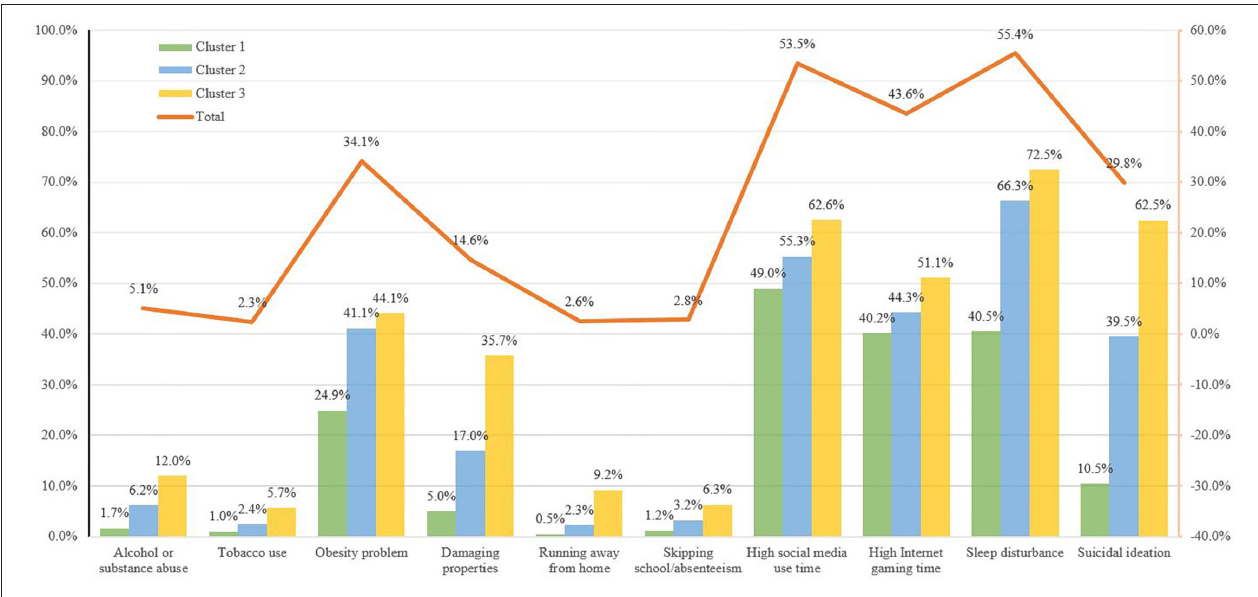
FIGURE 4 | Frequency of behavioral, Internet use, and mental health problems by